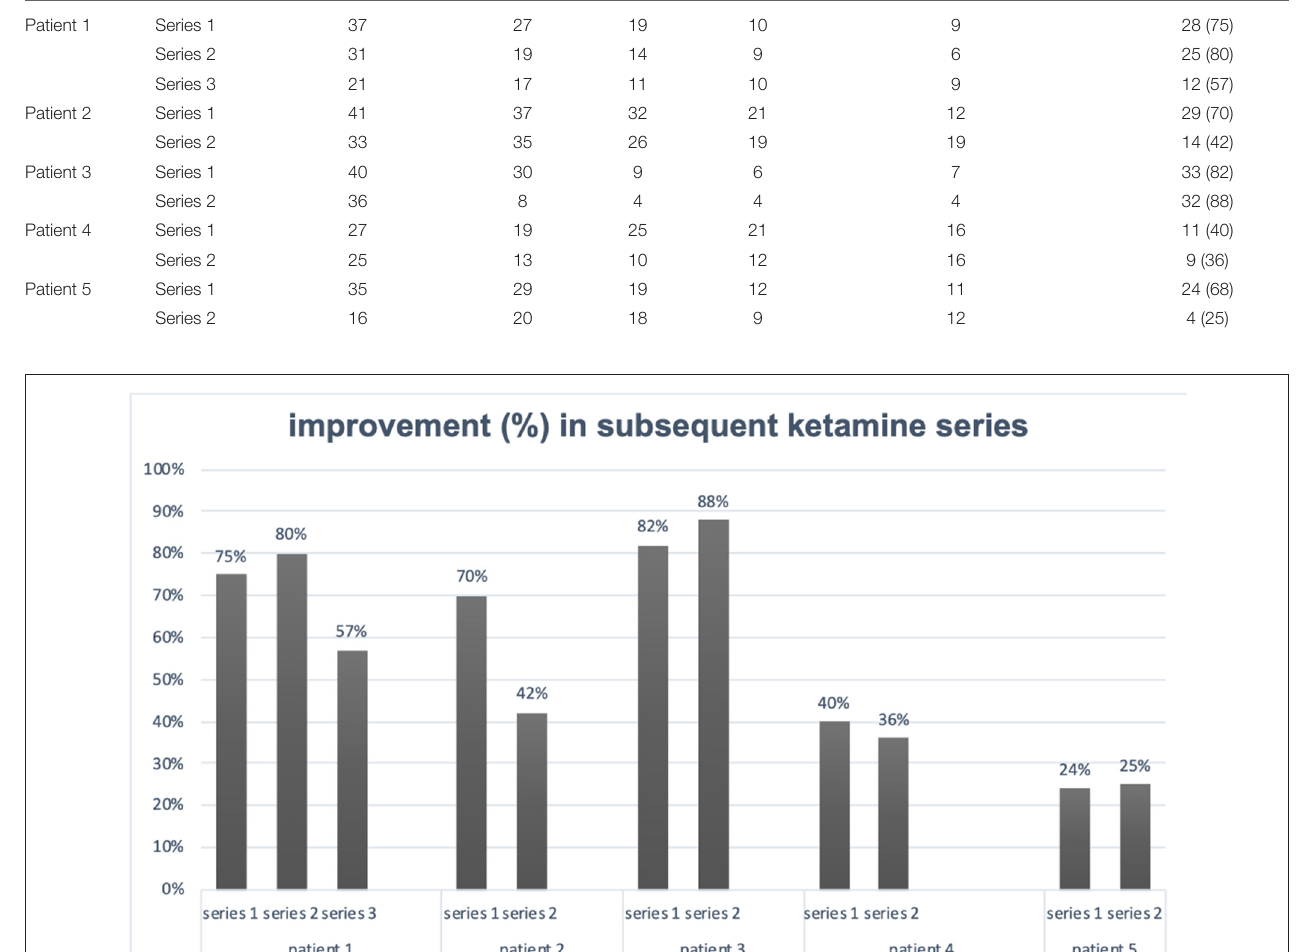
Pre-treatment MADRS scores: